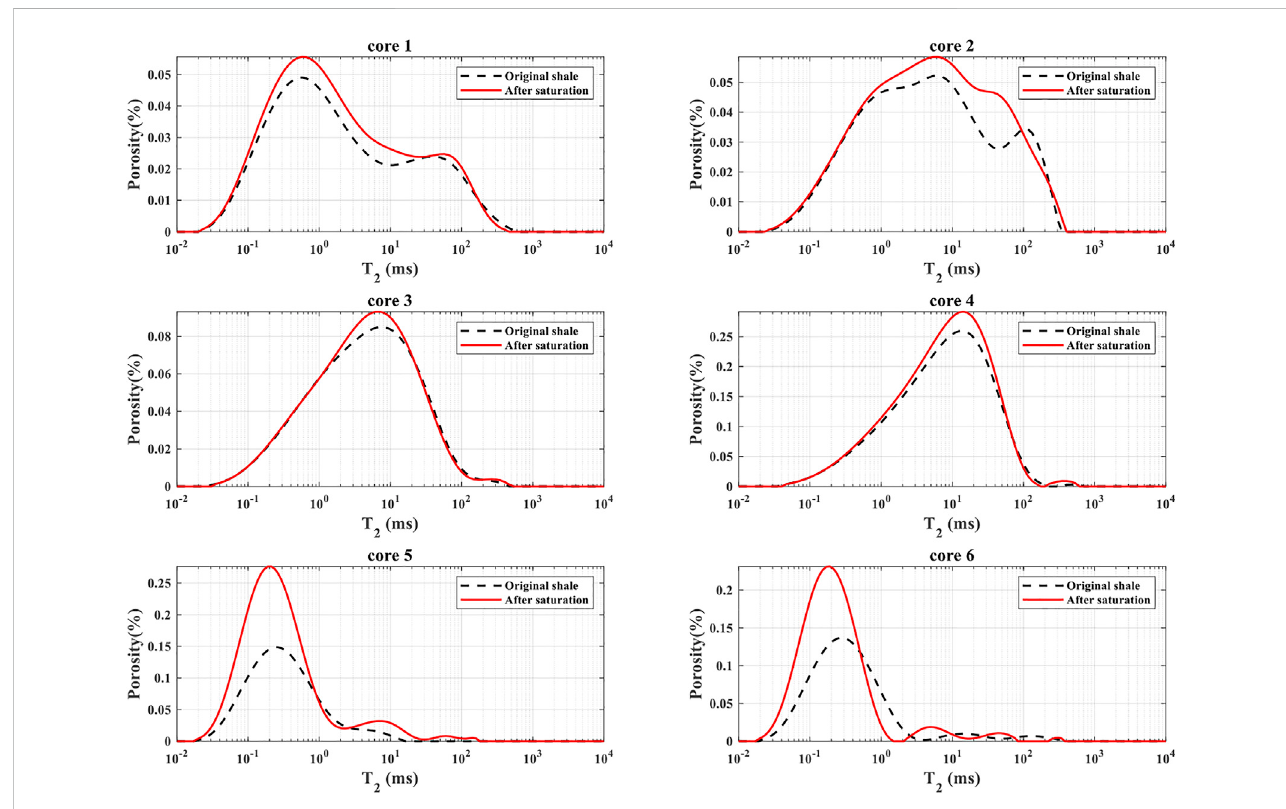
T 2 NMR experiment results of shale